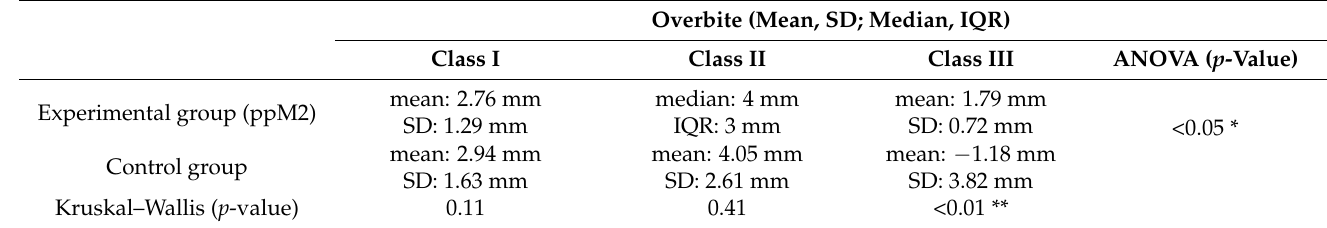
Figure 7. Relationship between overbite and angle-classification in the experimental and control group. Table 7. Overbite in experimental and control